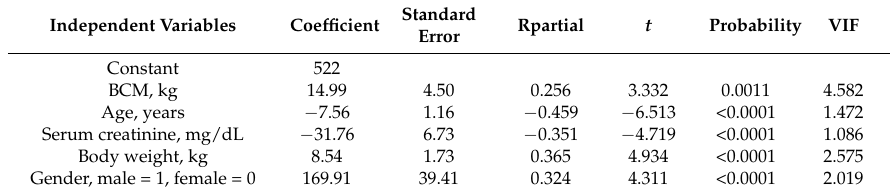
Table 2. Multiple linear regression modeling (stepwise) for creatinine excretion (mg/24 h) based on body cell mass (BCM), age, body weight, serum creatinine, gender, height. VIF (Variance inflation factor). Coefficient of determination r 2 = 0.7454, multiple correlation coefficient = 0.8634.